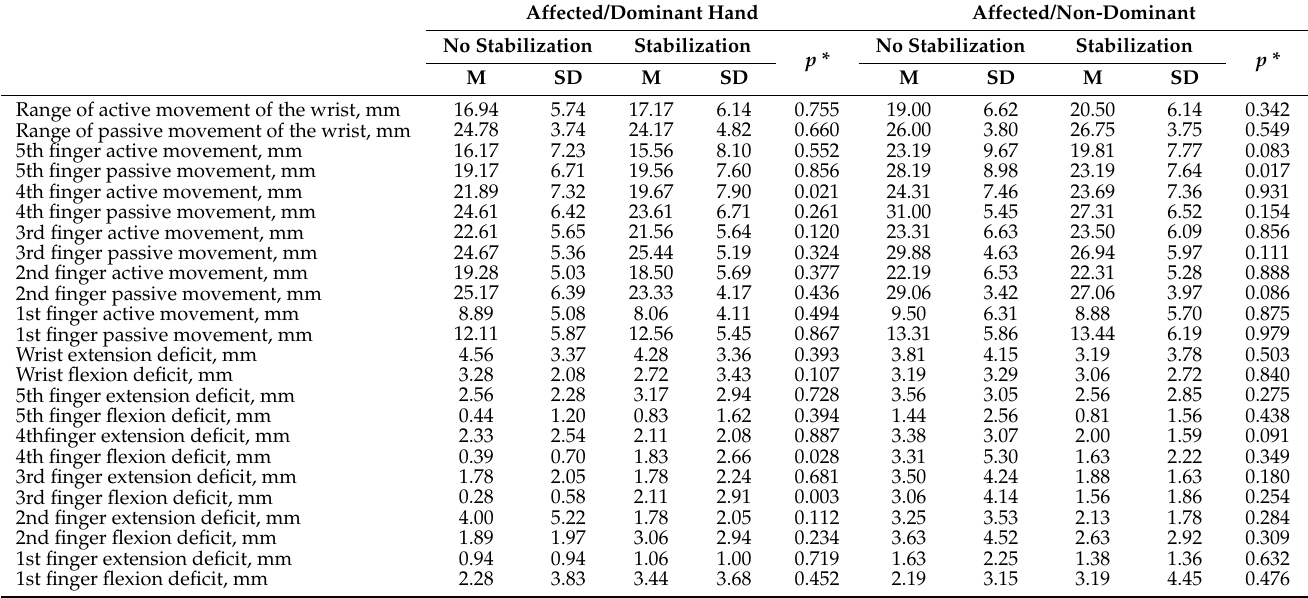
Table 5. Effect of hand dominance on motor coordination of the hand and wrist in stroke patients with and without stabilization of the trunk and upper